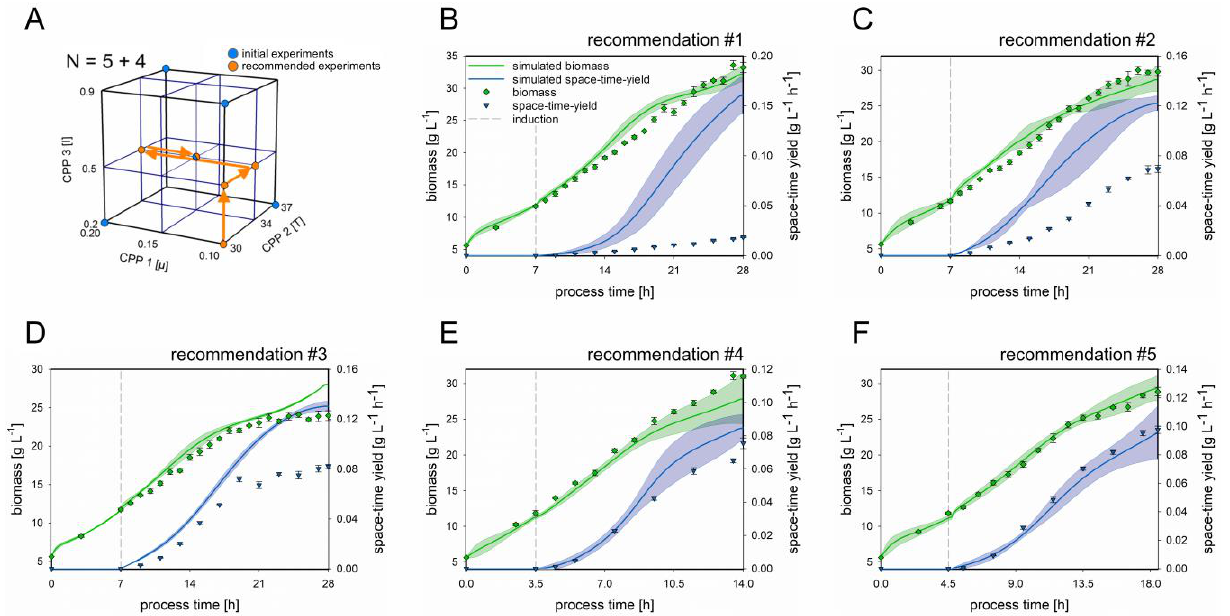
Figure 4. Step-by-step progression of the model-based DoE and the performance compared to experimental data. The initial data set (blue circles), the recommended experiments (orange circles), and the temporal order (orange arrows) are given ( A ). For each recommended experiment ( B – F ), the simulated biomass (green lines) and the simulated space-time yield (blue lines) are presented along with the PI (shaded area). The time point of induction (dashed grey line) and the mean analytical values for the biomass (green diamonds) and the space-time yield (blue triangles) are indicated along with the SD (error bars).